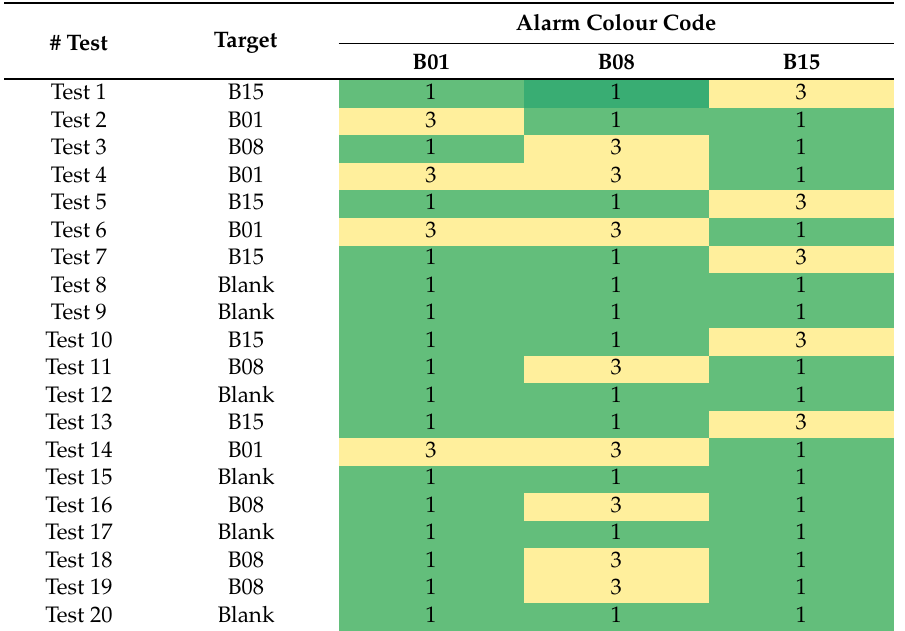
Table 12. Results obtained for the EC sensor during the tests performed during the final demonstration at FOI.